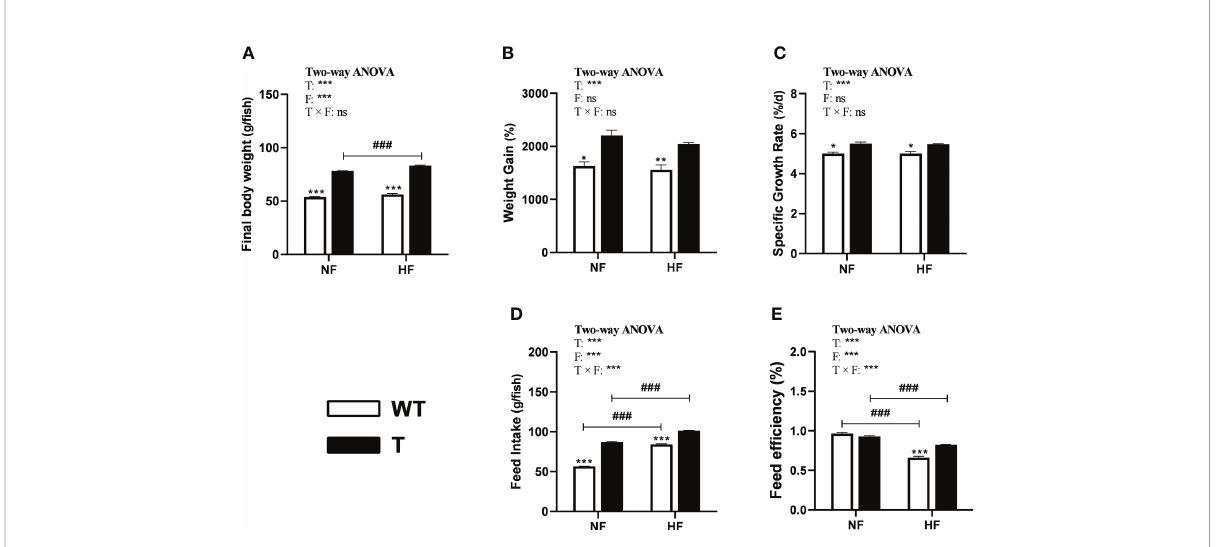
FIGURE 5 Effects of GH overexpression on growth performance in common carp fed different lipid levels diets. NF diet, 6% lipid; HF diet, 12% lipid. (A – E) Final body weight, Weight gain, Speci fi c growth rate, Feed intake, and Feed ef fi ciency of wild-type (WT) and GH transgenic (T) common carp. *, ** and *** mean signi fi cant differences ( P < 0.05), ( P < 0.01) and ( P < 0.001) at same dietary lipid content for different strains. ### means signi fi cant difference ( P < 0.001) between different lipid content for one strain. In two-way ANOVA analysis, T, GH transgenic. F, fat, *** P < 0.001. ns, no signi fi